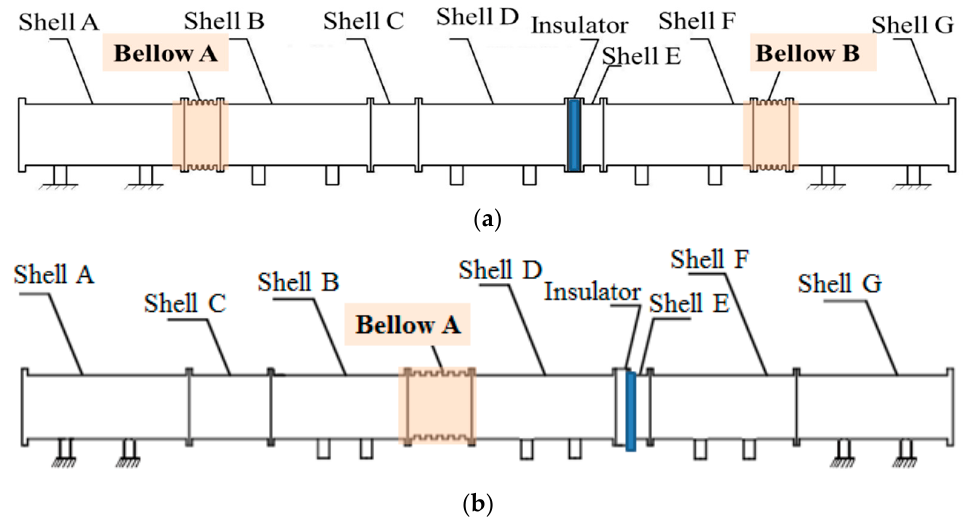
Figure 4. Schematic diagram of the site layout scheme of the case analysis object: ( a ) distributed layout; ( b ) centralized layout. Table 1. Axial length of case object structure.